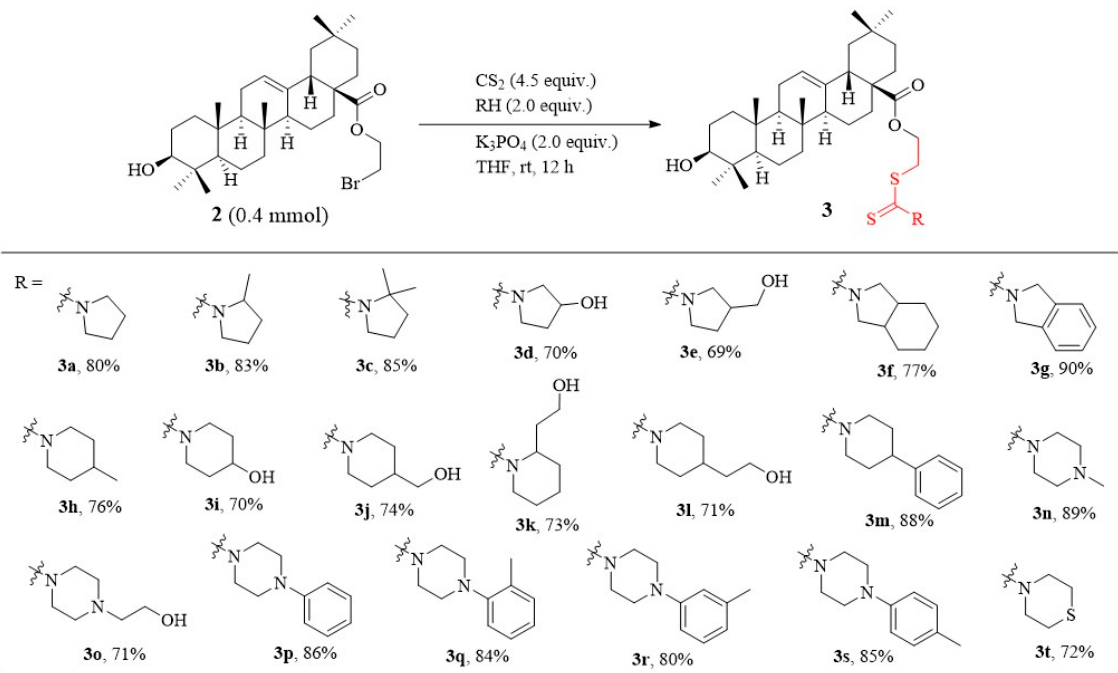
Figure 1. Synthesis of OA-Dithiocarbamate Derivatives.